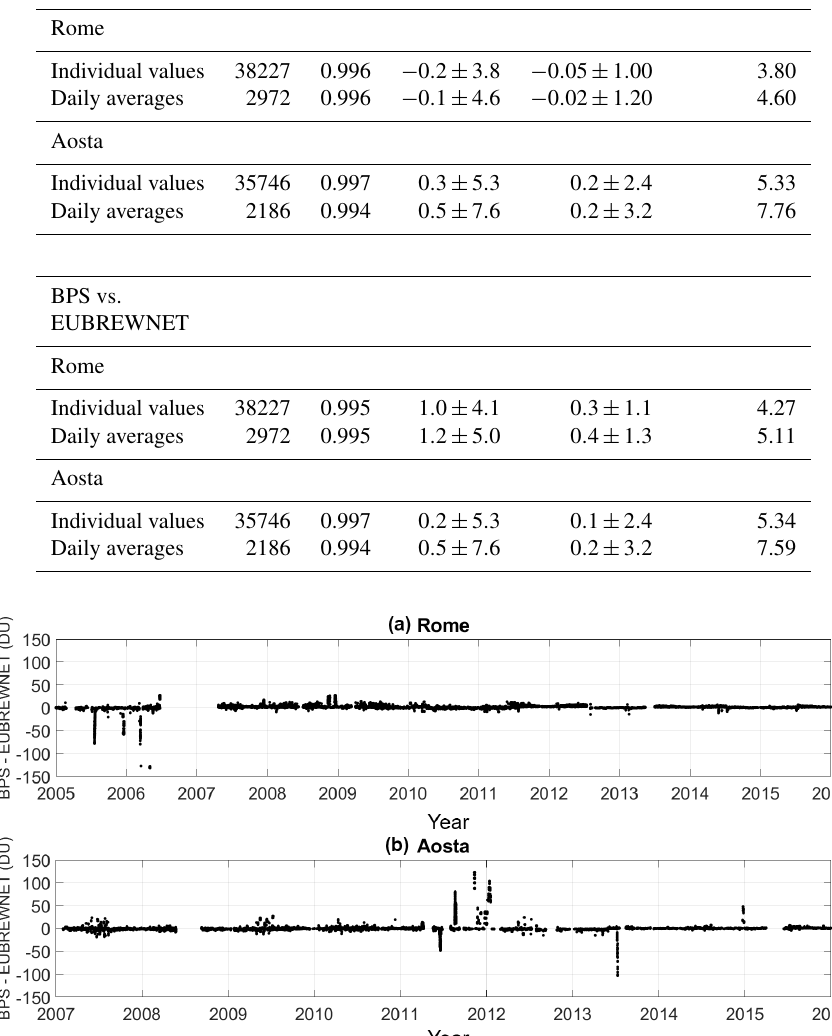
Figure 13. Difference between individual TOC values generated by BPS and EUBREWNET ( a , Rome; b ,